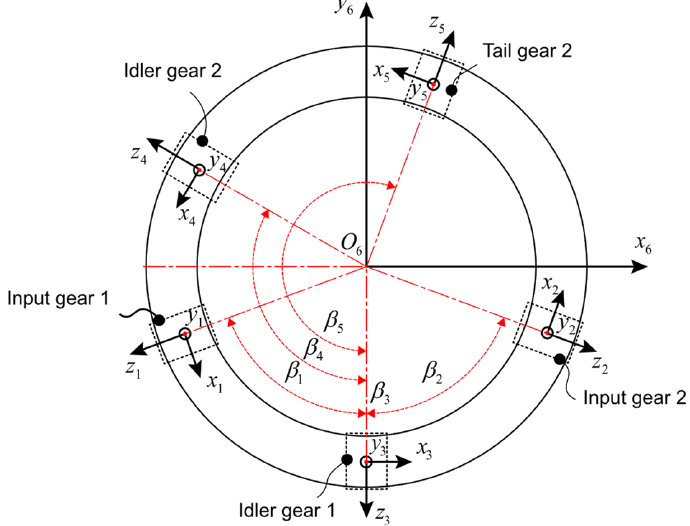
Figure 9. Distribution of pinions around circumference of face gear.